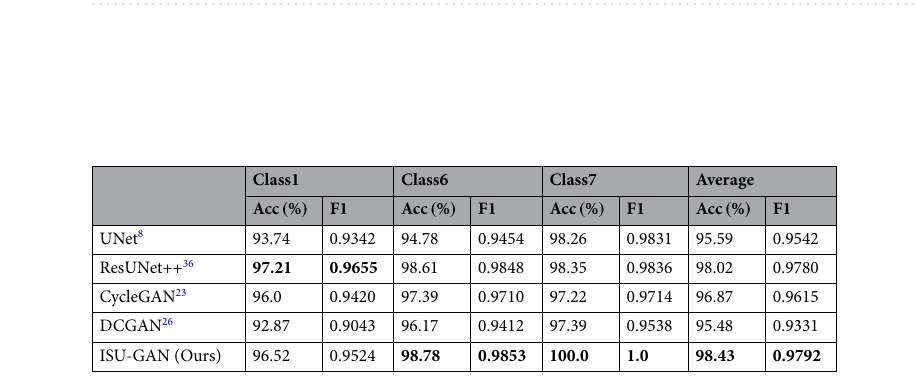
Table 2. Comparing Accuracy and F1-score in ISU-GAN and other segmentation models. 1 The GAN Discriminators for the experiments use the Markov Discriminator 30 . Significant values are in